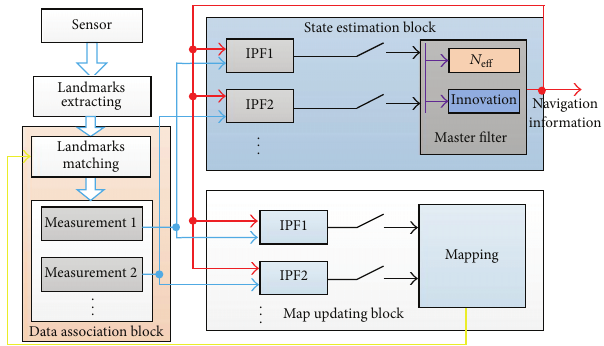
Figure 2: The structure of improved DPF SLAM